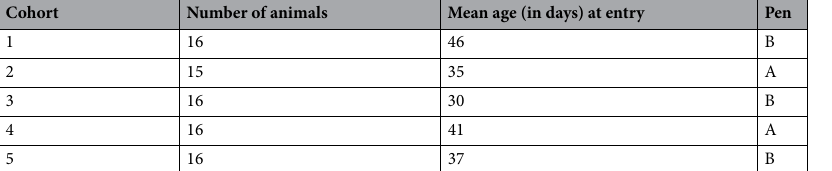
Cohort Number of animals Mean age (in days) at entry